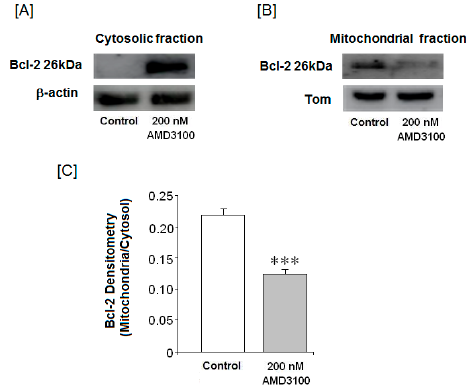
Figure 6. Effect of AMD3100 on Bcl-2 protein levels. Western blot analyses of Bcl-2 protein in ( A ) the cytosol and ( B ) the mitochondria; ( C ) average of densitometry in three different membranes. Results are means ± SEM from the three membranes densitometry. The statistical significance was evaluated by t -Student test using Sigma Plot 11 software. Differences were considered significant at p < 0.05. The asterisk indicates statistical significance as compare to control. *** p < 0.001.